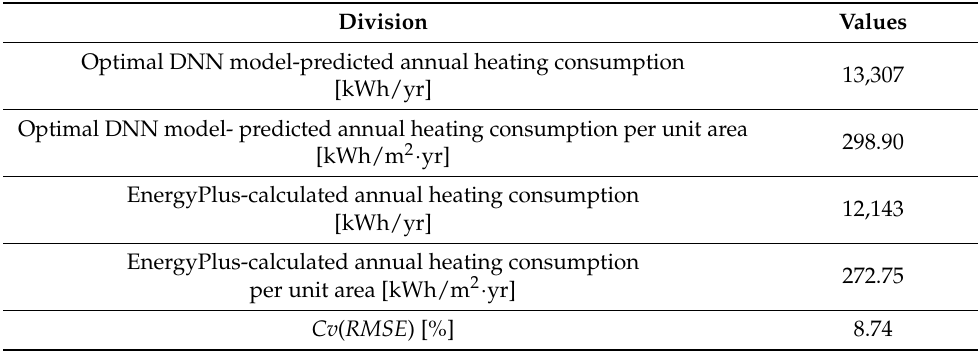
Table 9. Cv ( RMSE ) of heating energy consumptions predicted by the optimal DNN model to those calculated by EnergyPlus for the standard house.